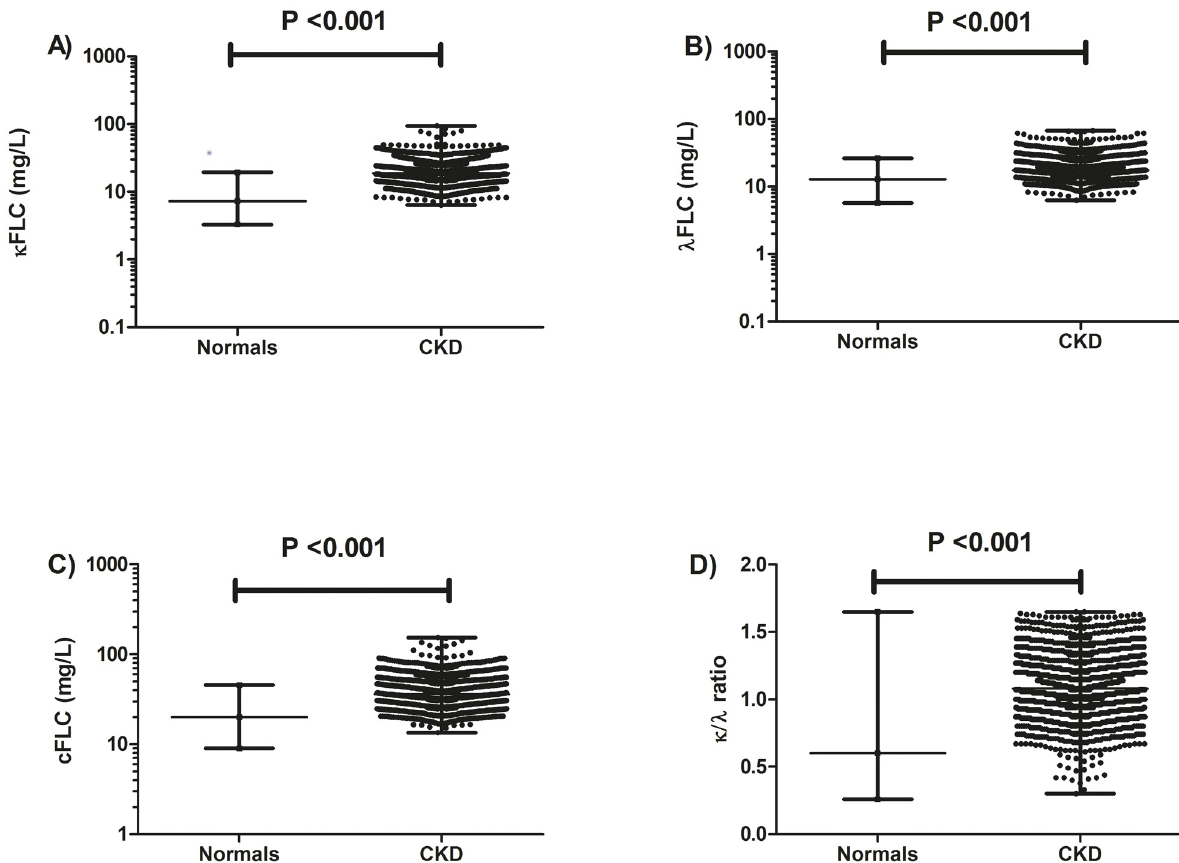
Fig 2. Serum FLC concentration in people with stage 3 chronic kidney disease versus normal controls. A) κ free light chains (FLC), B) λ FLC and C) Combined free light chains (cFLC) levels were elevated in people with chronic kidney disease (CKD) (circles) versus published normal control individuals [21]. D) The FLC κ / λ ratio was also significantly higher in people with CKD compared to the healthy control population. Median and ranges are indicated (black bars).